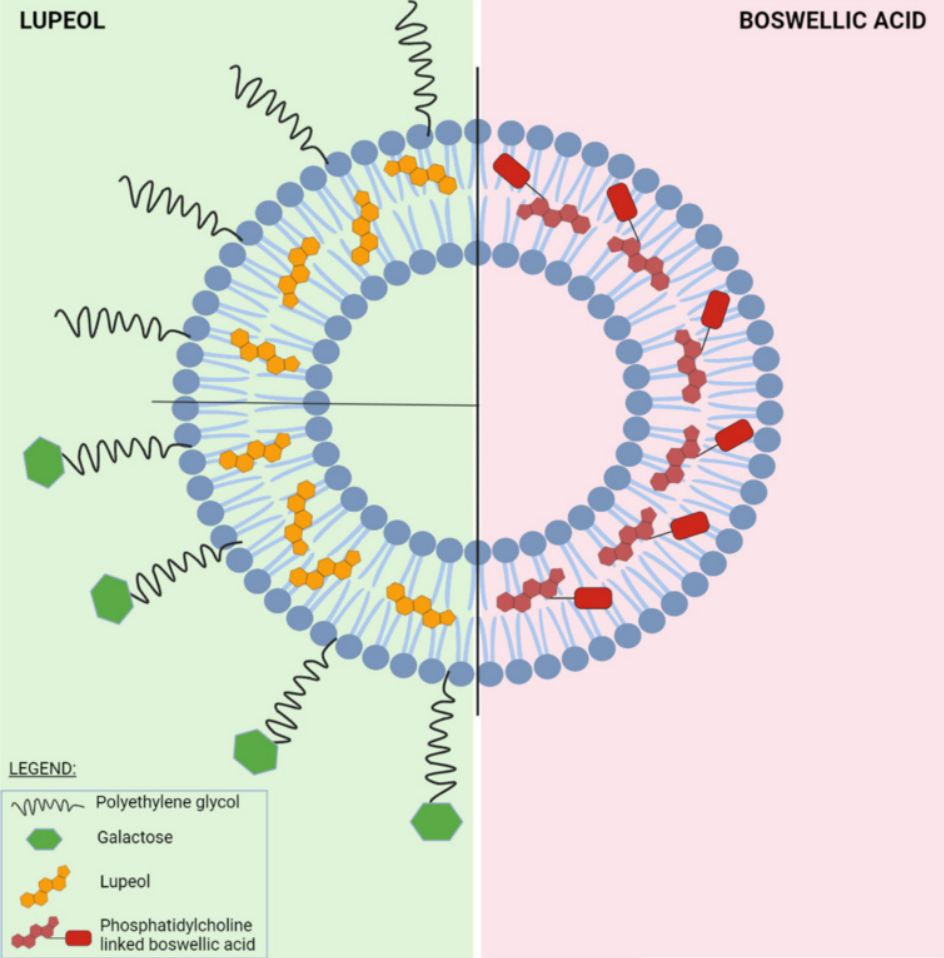
Figure 25. Schematic representation of different reported lupeol and BwA liposomal formulations. Created with BioRender.com (accessed on 10 January